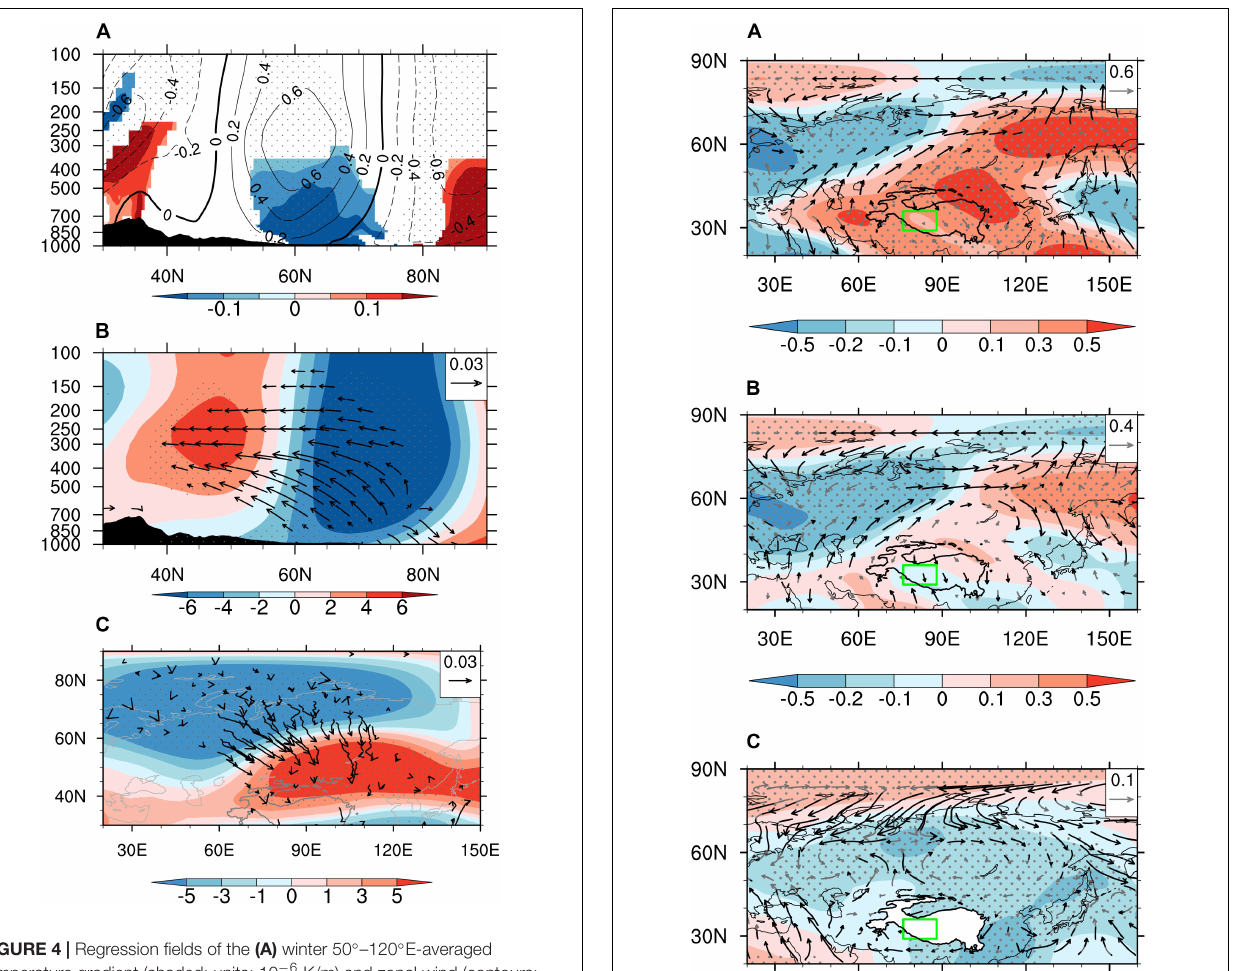
FIGURE 4 | Regression fields of the (A) winter 50 ◦ –120 ◦ E-averaged temperature gradient (shaded; units: 10 − 6 K/m) and zonal wind (contours; units: m/s), (B) 50 ◦ –120 ◦ E-averaged geopotential height (shaded; units: m) and the TN Rossby wave activity flux in the vertical (vectors; units: m 2 /s 2 ), and (C) 250-hPa geopotential height (shaded; units: m) and the TN Rossby wave activity flux (black vectors; units: m 2 /s 2 ) in the horizontal, against the BSICI. The contour and shaded values of the stippled area in A and B, C exceed the p = 0.1 confidence level. The shaded value in A exceeds the p = 0.1 confidence level. The gray line over the (25 ◦ –45 ◦ N, 60 ◦ –110 ◦ E) in C outline the 2-km topography of the Tibetan Plateau.